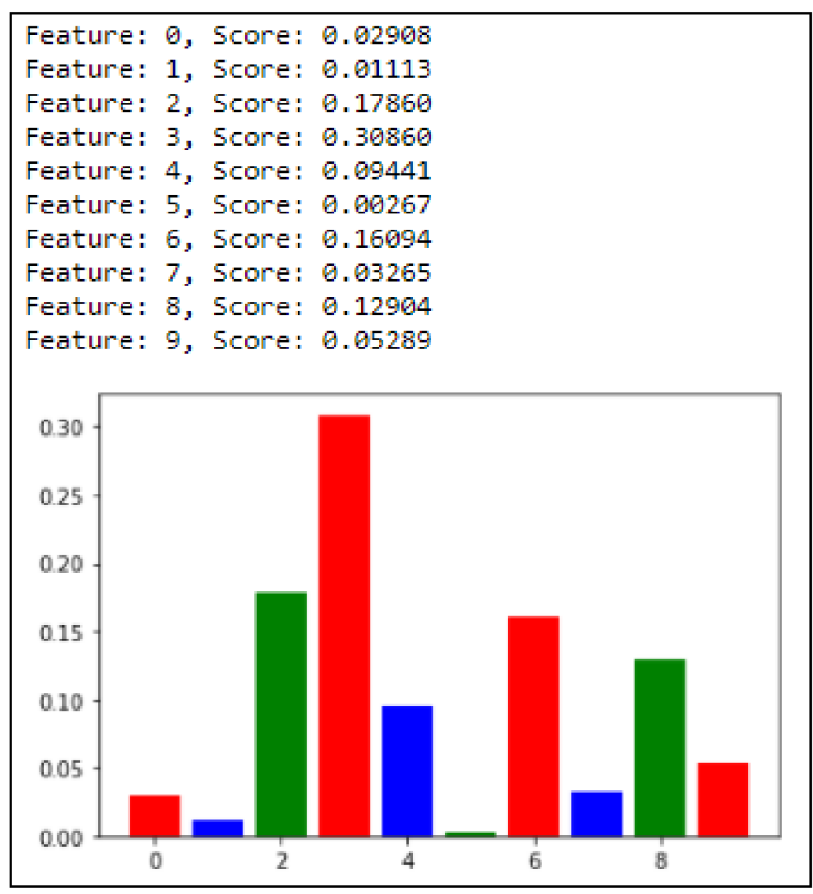
Figure 13. Feature importance graph for decision tree.